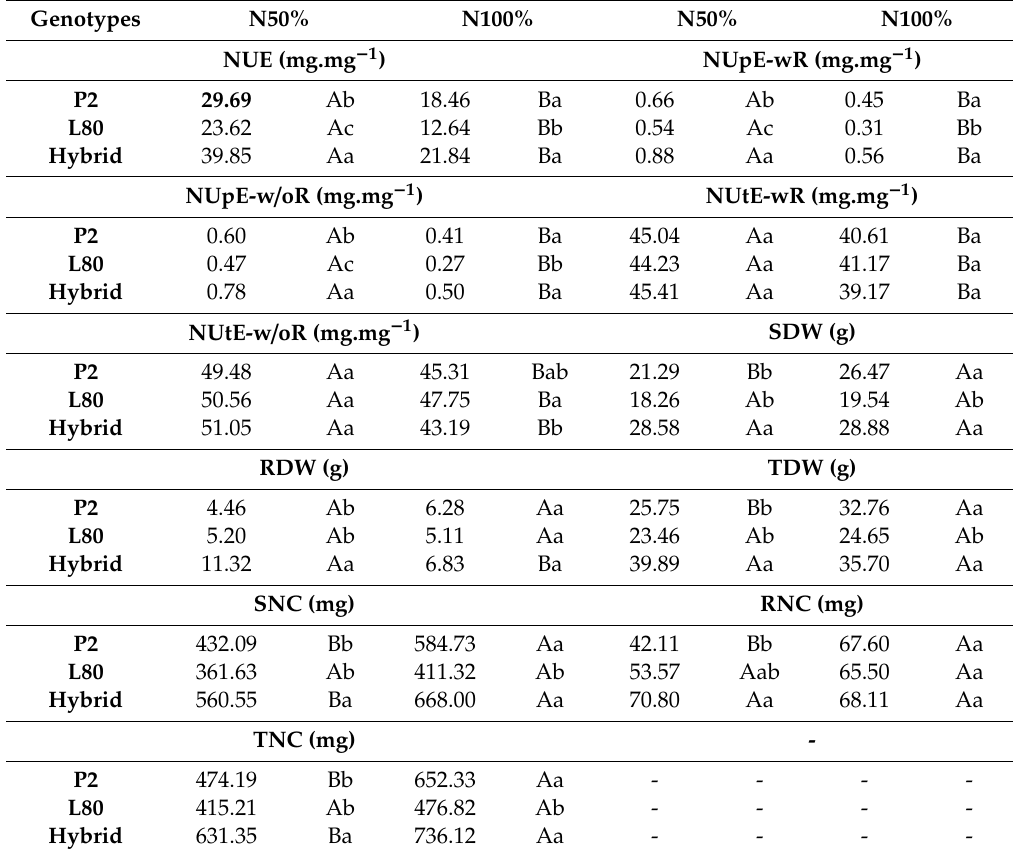
Table 3. Mean values of popcorn genotypes for the dry weight, N content, nitrogen use, uptake and utilization e ffi ciency under two di ff erent N level at the VT